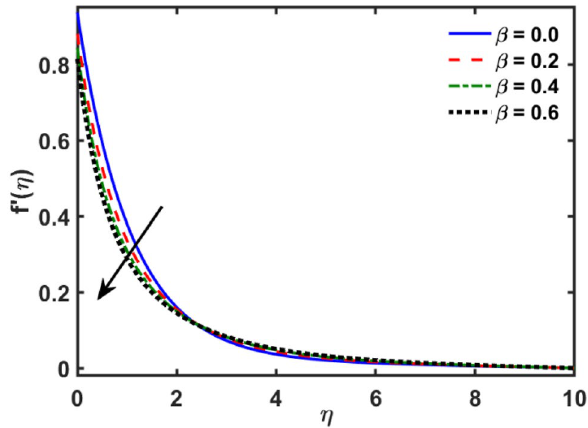
Figure 2. Variation of β on f ′ (η) .